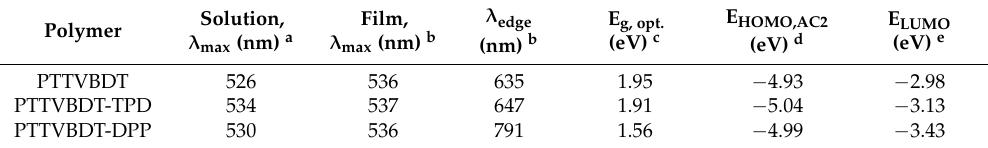
Table 2. Optical and electrochemical properties of the polymers.